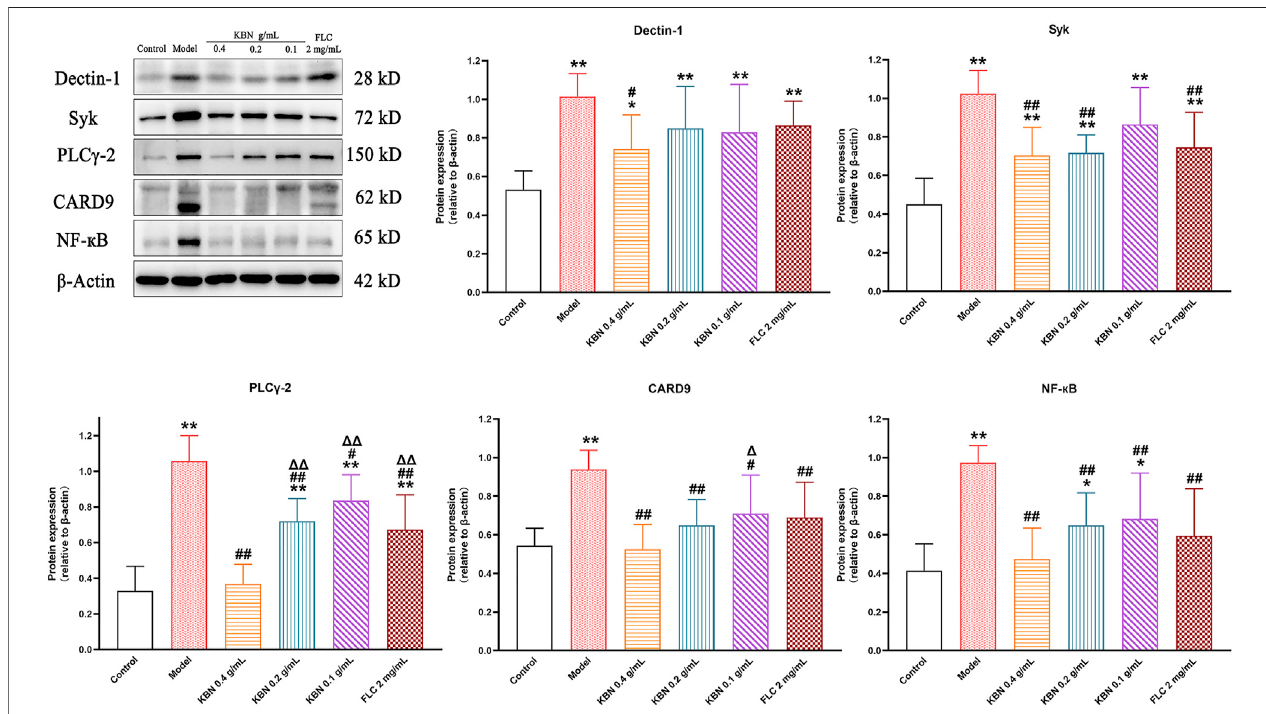
FIGURE 10 | Effect of KBN on the protein expression of Dectin-1, Syk, PLC γ -2, CARD9, and NF- κ B in the vaginal tissues. N (cid:1) 6. Each value is presented as the mean ± SD. * p < 0.05, ** p < 0.01 as compared to the control group; # p < 0.05, ## p < 0.01 as compared to the model group; △ p < 0.05, △△ p < 0.01 as compared to the KBN 0.4 g/mL